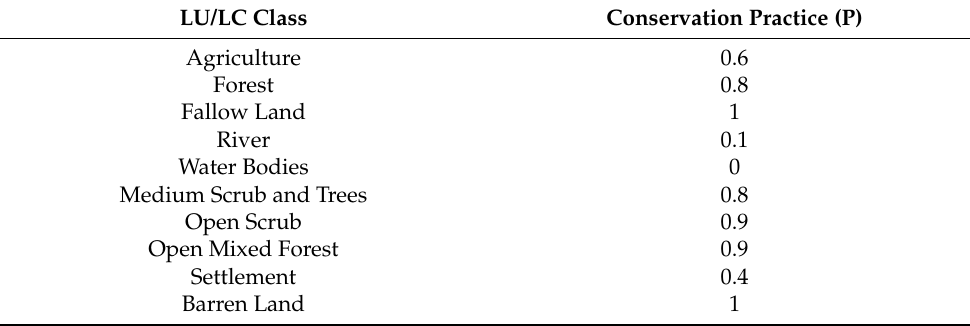
Table 2. LULC wise Conservation Practice